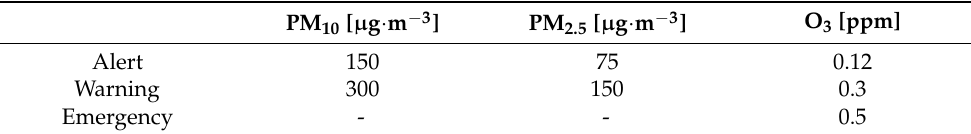
Table 3. Thresholds for the air quality warning system in Korea.